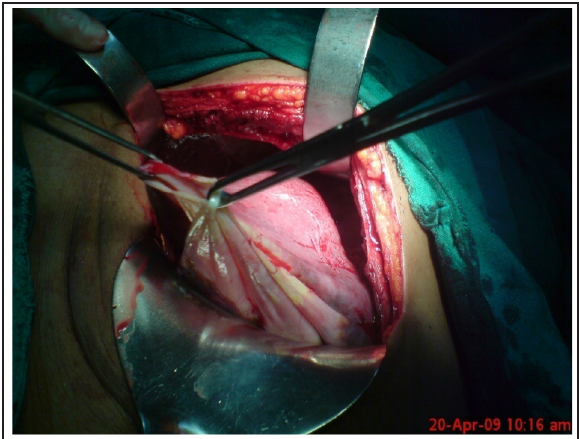
Figure 2. Peroperative photo after aspiration of splenic cyst in male patient.